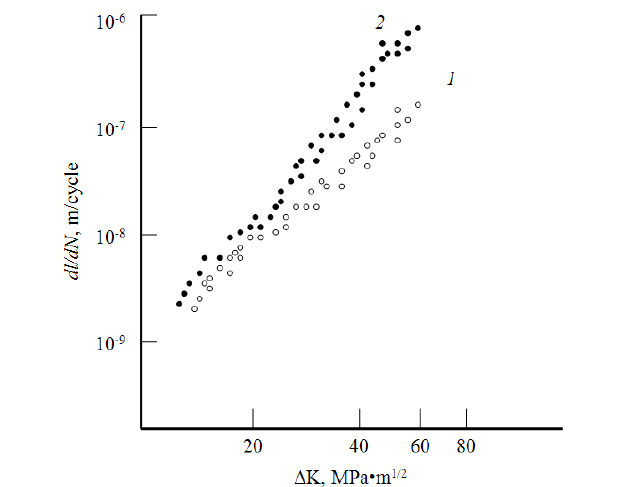
Figure 2: Fatigue crack growth behaviour: 1 - uncharged specimens, 2 - hydrogen-charged